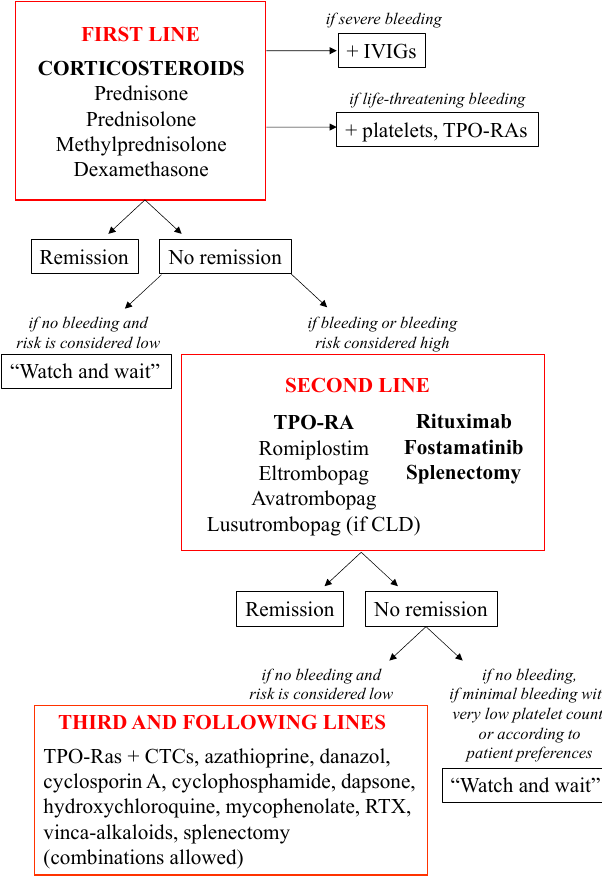
Figure 2. Treatment preferences to manage ITP, according to the current guidelines. Splenectomy should not be considered an option during the first 12 months after diagnosis. Third-line treatments are not necessarily arranged according to hierarchy. Note: CLD, chronic liver disease; CTC, corticosteroids; ITP, primary immune thrombocytopenia; IVIGs, intravenous immunoglobulins; RTX, rituximab; TPO-RAs, thrombopoietin receptor agonists.